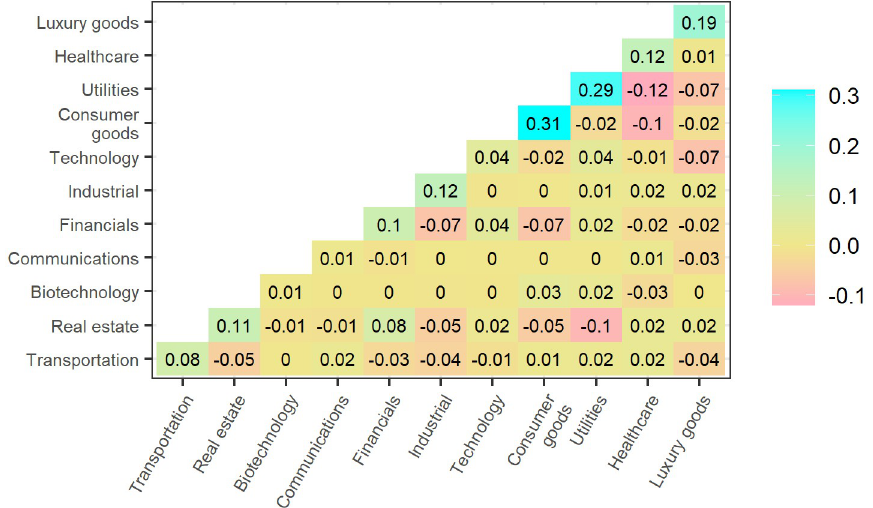
Fig 5. The financial data correlation matrix minus the approximate correlation matrix calculated as the outer product of the 6 leading loadings.